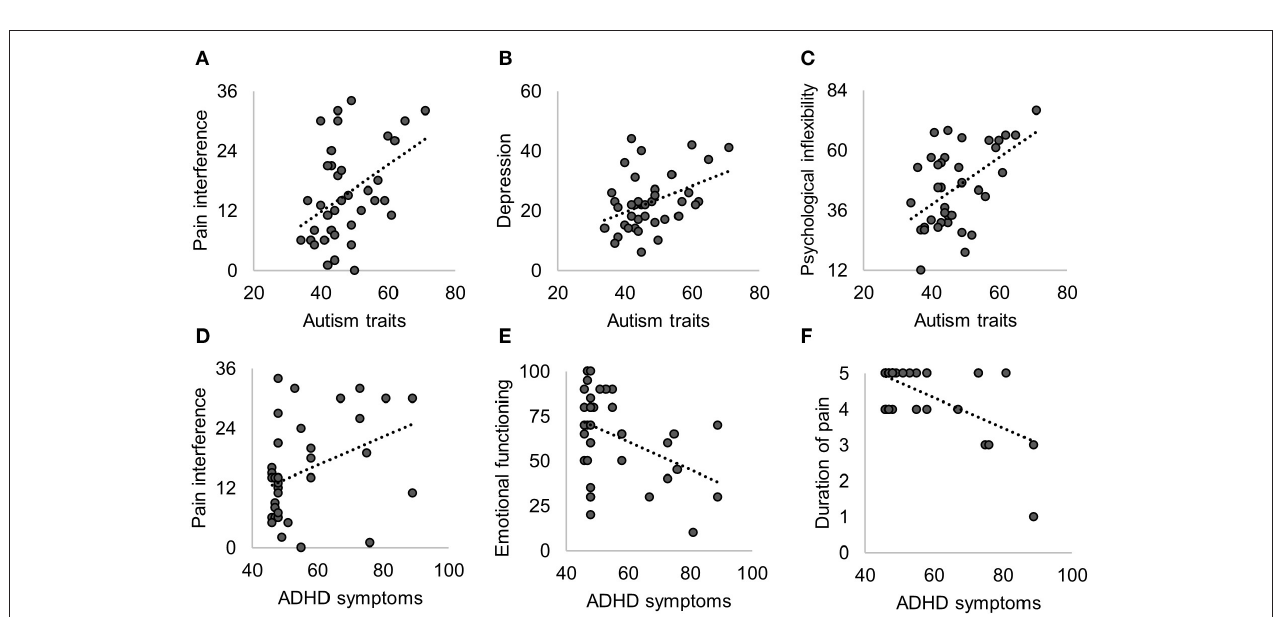
FIGURE 1 | Significant Pearson correlations of pretreatment functioning with autism traits (A–C) and with ADHD symptoms (D–F) . Non-significant correlations are shown in Table 2 and Supplementary Figure 1 .